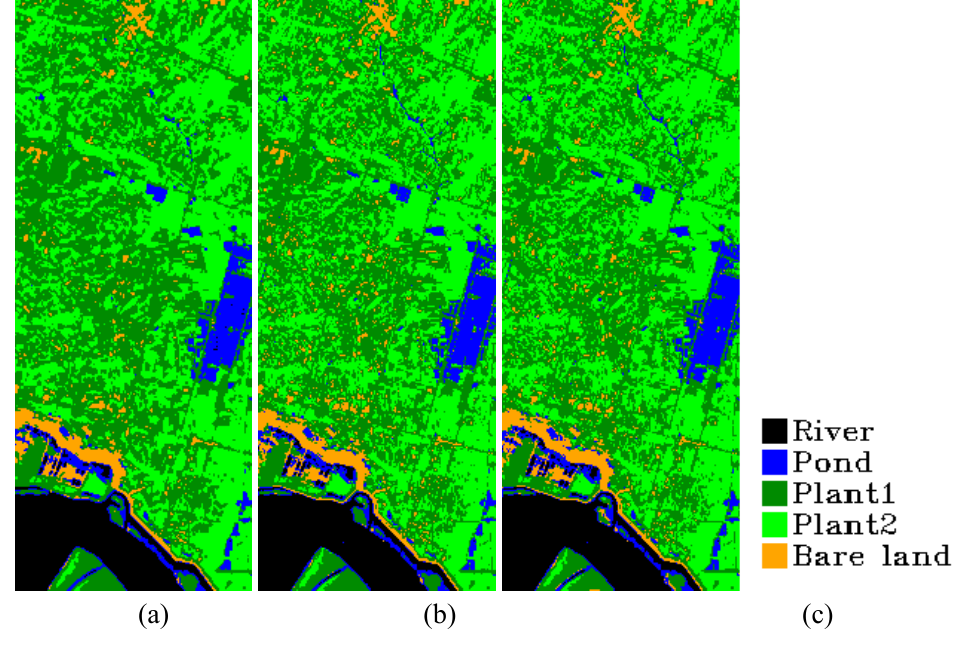
Figure 7 . Classification results of original Hyperion data, simulated Hyperion data, and ALI data: (a) shows the classification image of original Hyperion data, (b) shows the classification image of simulated Hyperion data, and (c) shows the classification image of ALI data. (Class label “pond” refers to water, which has characteristics of pond water;